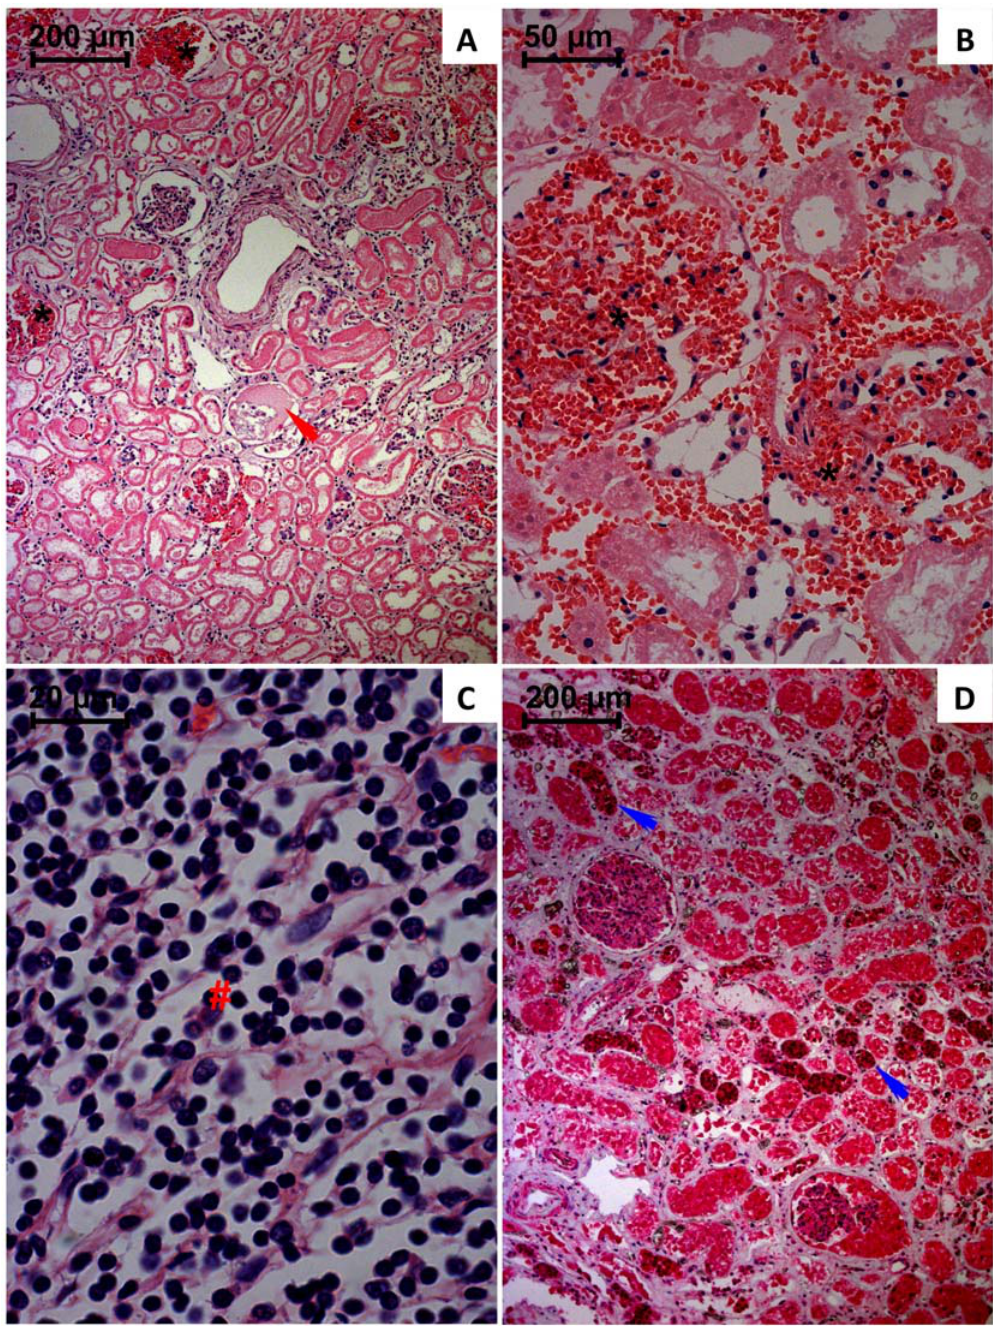
Figure 4. Light micrographs of kidneys from paraquat human fatal poisonings stained with hematoxylin-eosin (A–C) and immunohistochemistry analysis for NF- k B (D). In A and B it is observed marked vascular congestion within glomeruli and extraglomerular space (*); coagulation necrosis of glomeruli is also depicted (red arrow). Histology also revealed a widespread necrosis of tubular cells affecting more intensively the proximal convulated tubules. In C, pronounced density of mononuclear cells ( # ) within capillaries also infiltrating tissue. In D, NF- k B activation is generalized but particularly more intensive in the tubular distal convoluted tubules (blue arrow).